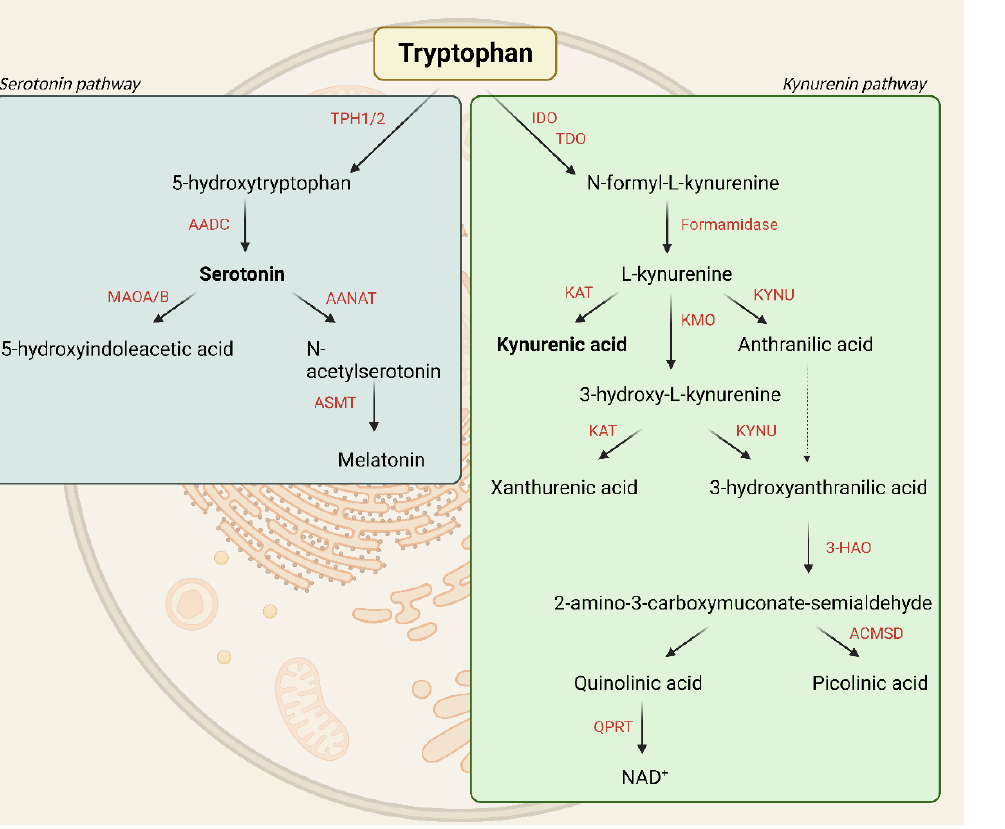
Figure 1. The two main pathways of tryptophan metabolism: serotonin and kynurenine pathways.